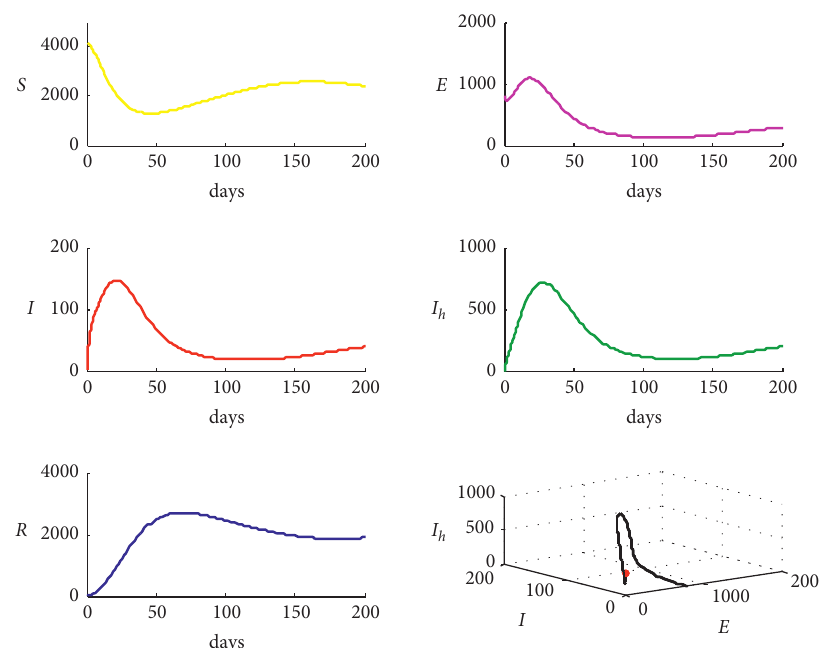
Figure 1: The trajectory of system (1) approaches to endemic equilibrium